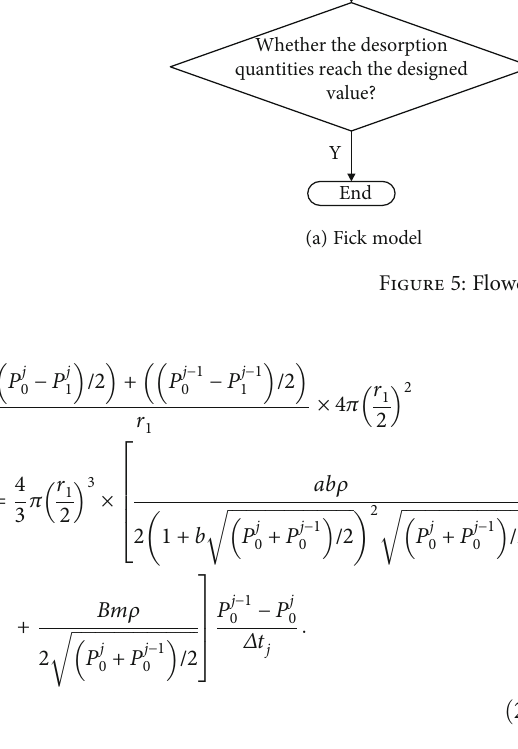
ffiffiffiffiffiffiffiffiffiffiffiffiffiffiffiffiffiffiffiffiffiffiffiffiffiffiffi